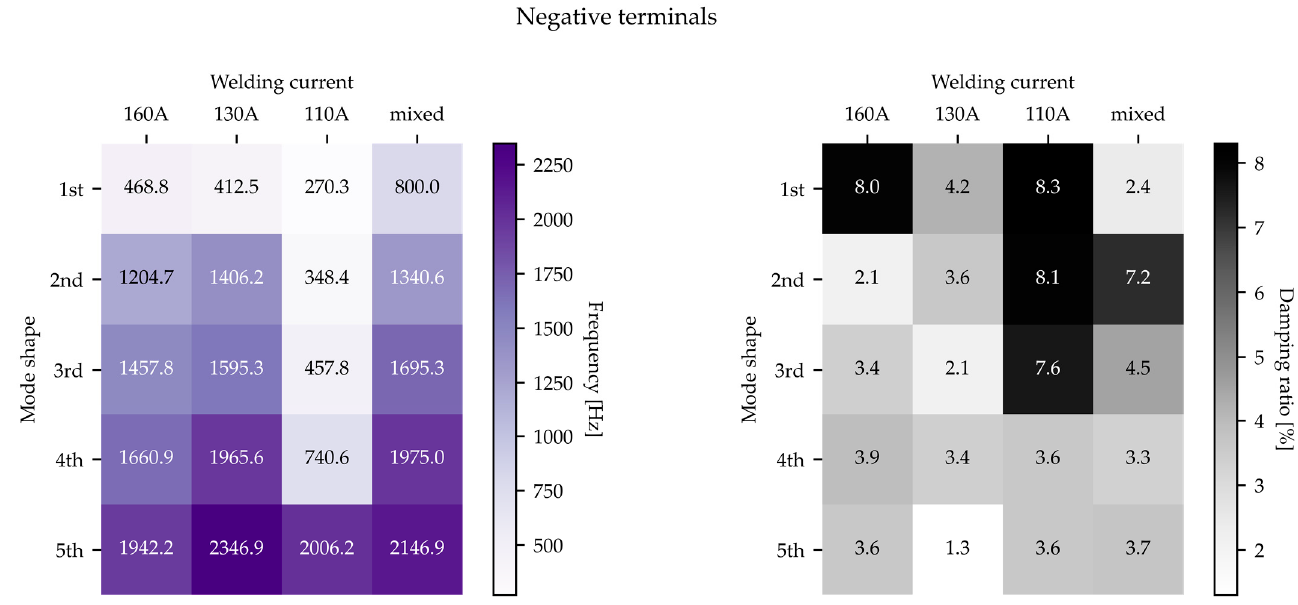
Figure 12. Heatmaps of resonance frequencies and damping ratios of supercells observed from the negative terminals, with respect to welding current and mode number.